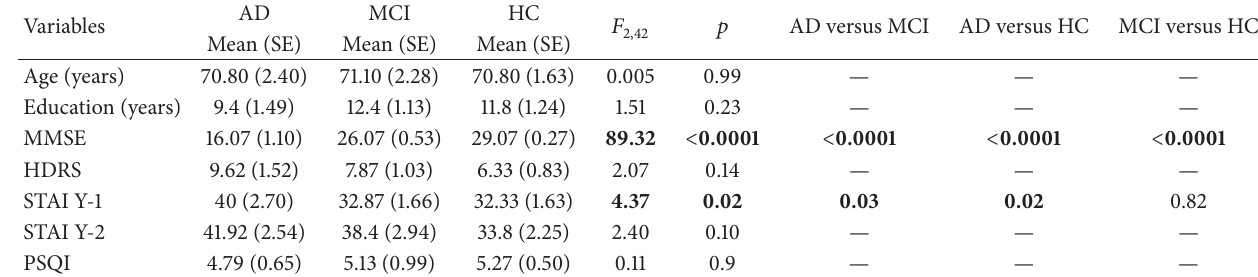
Table 1: Mean and standard errors (SE) of demographic (age, education) and clinical (Minimental State Examination (MMSE) scores, Hamilton Depression Rating Scales (HDRS) scores, State Trait Anxiety Index (STAI Y-1 and STAI Y-2) scores, Pittsburg Sleep Quality Index (PSQI) scores) characteristics of AD patients, amnesic MCI patients, and HC. The results of the one-way ANOVAs ( 𝐹 and 𝑝 values) were also reported, with post hoc unpaired 𝑡 -test ( 𝑝 values) when ANOVAs were significant ( 𝑝 ≤ 0.05 ). Significant between-groups differences are indicated in